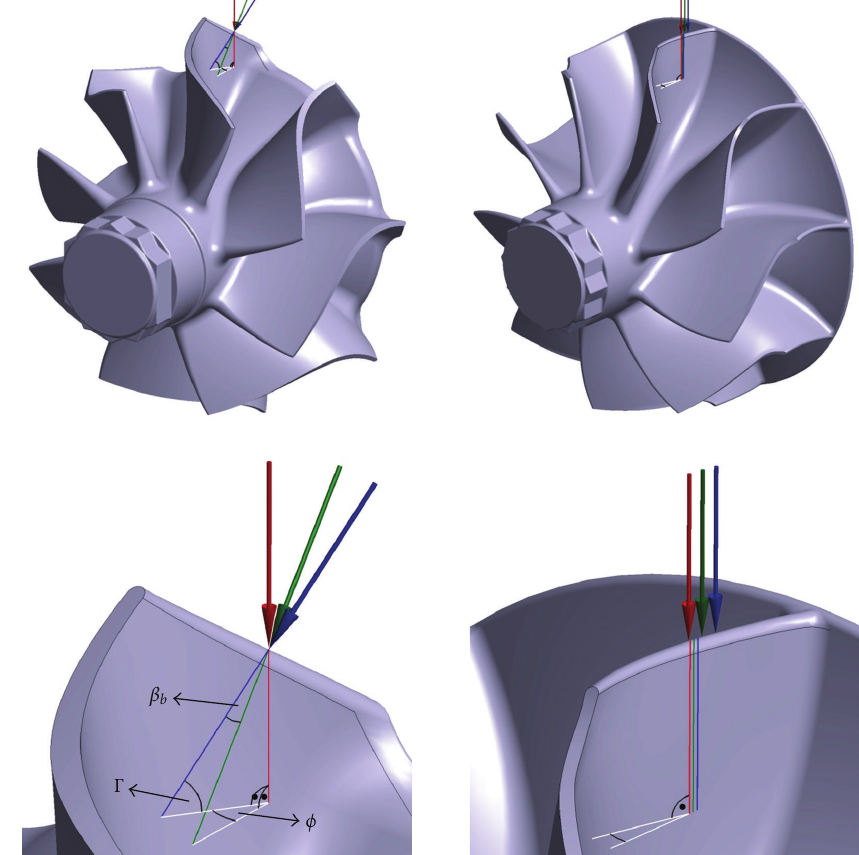
Figure 8: Degrees of freedom for mixed flow and radial flow turbines.